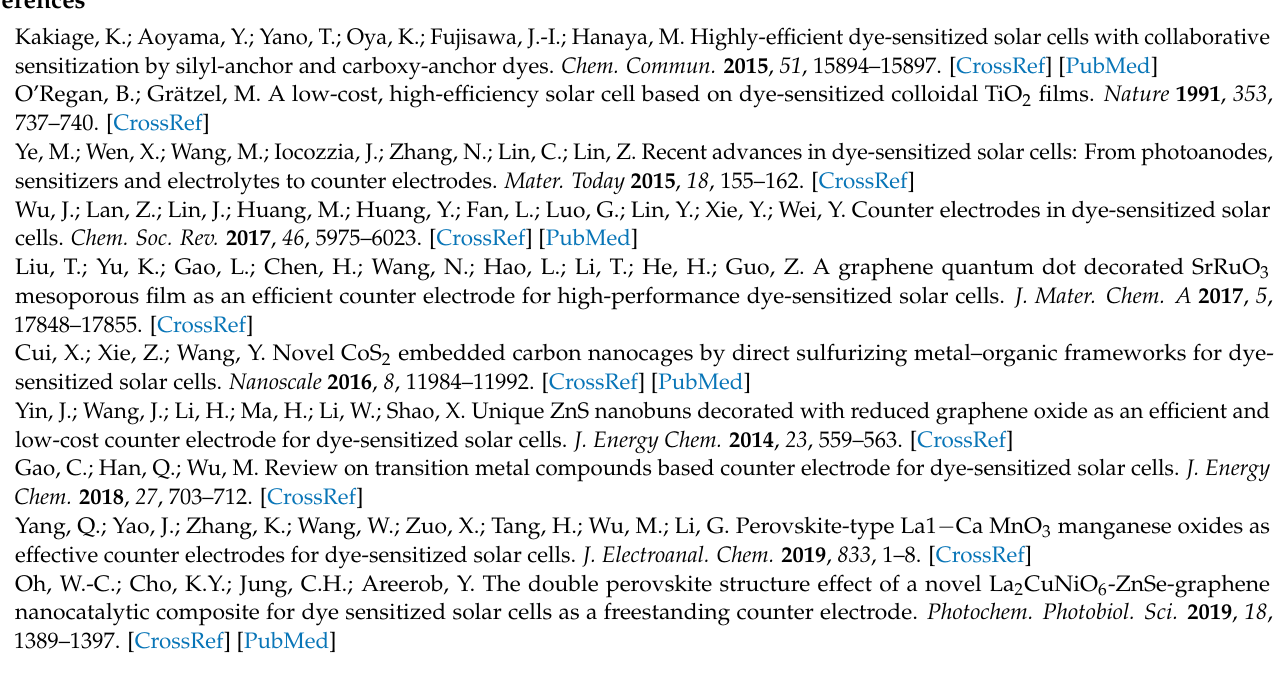
Table S1: CV, EIS, and Tafel polarization parameters for 2-L@F@CB CEs with various film thicknesses, Table S2: Photovoltaic performance of DSSCs for 2-L@F@CB CEs with various film thicknesses under AM 1.5G illumination at 100 mW · cm − 1 , Figure S8: Comparison of Different Compounds’ Prices: